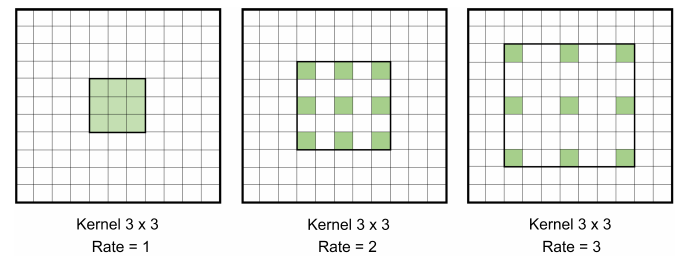
Figure 6. Atrous convolution kernel (green) dilated with different rates.